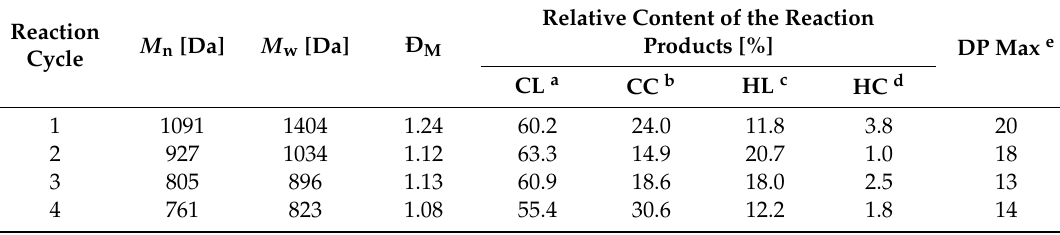
Table 4. Reuse e ffi ciency of the GF- Cal B-IM enzyme in multiple reaction cycles. Reaction